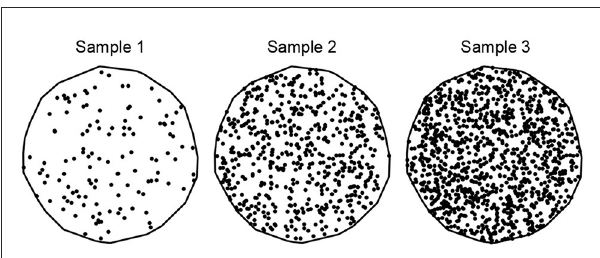
FIGURE3 An illustration of spatial point patterns with different spatial intensities. Samples 1, 2, and 3 have 20, 100, and 200 points per unit area,